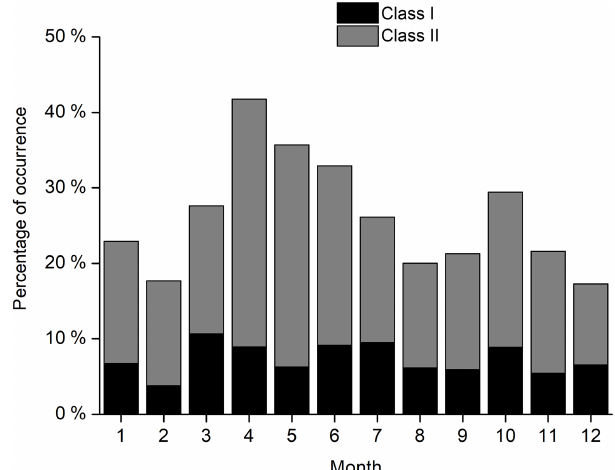
Figure 5. Seasonal variation in percentage of occurrence of NPF Class I and II events relatively to available measurement days at Finokalia in the eastern Mediterranean for the period June 2008– June